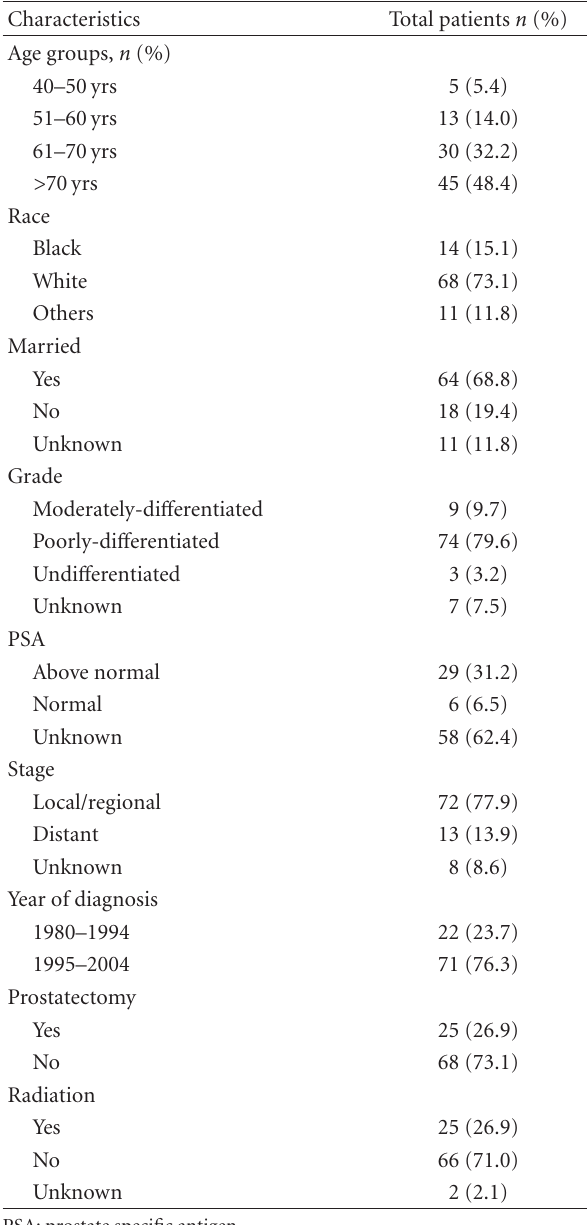
Table 2: Characteristics of 93 Patients with Signet Ring Prostate Carcinoma (Diagnosed Between January 1980 and December